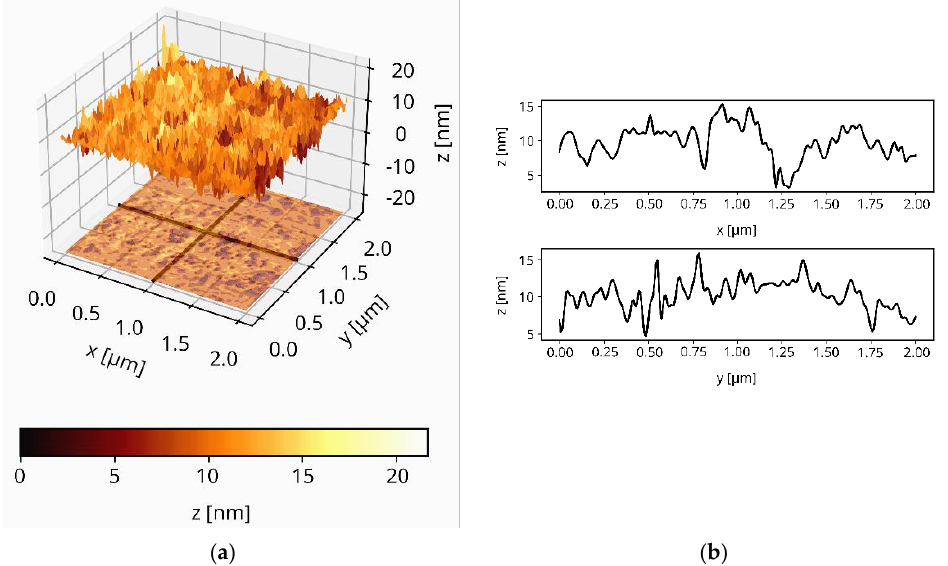
Figure 11. AFM surface topography images of the SiO 2 + PQXOH thin film deposited at 200 °C ( a ) and profiles in two cross-sections ( b ).